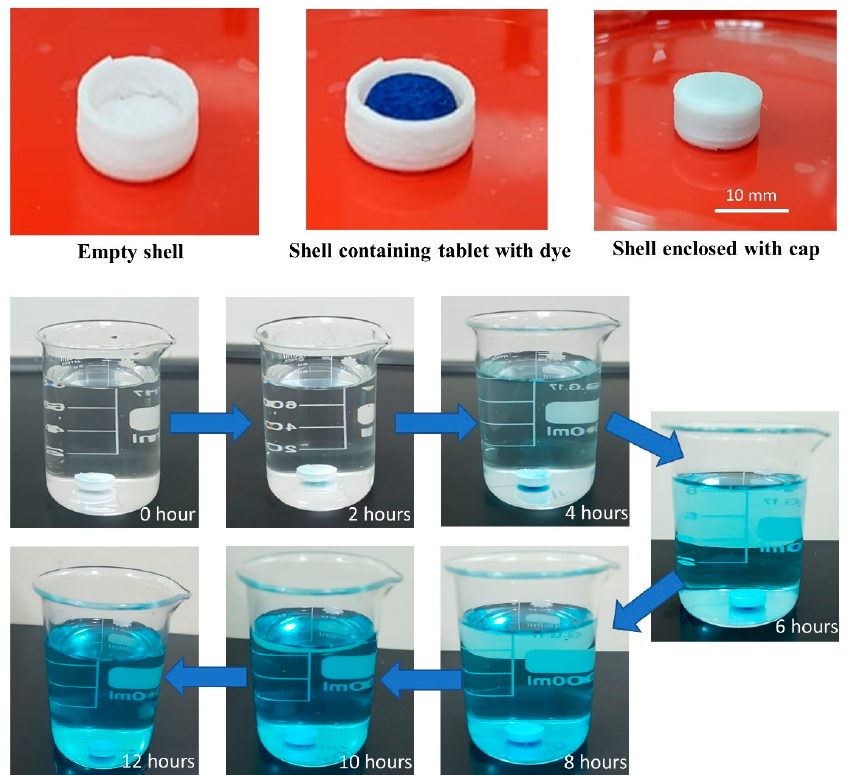
Figure 3. Illustration representing encapsulation of the propranolol HCl tablet soaked with color dye (methylene blue) kept inside 3D printed controlled-release shell, with the gradual increase in the intensity of the color solution showing the visual observation of methylene blue release through the 3D printed controlled-release shell at different time intervals. Table 3. Influence of different compositions of 3D printed controlled-release shell on % cumulative